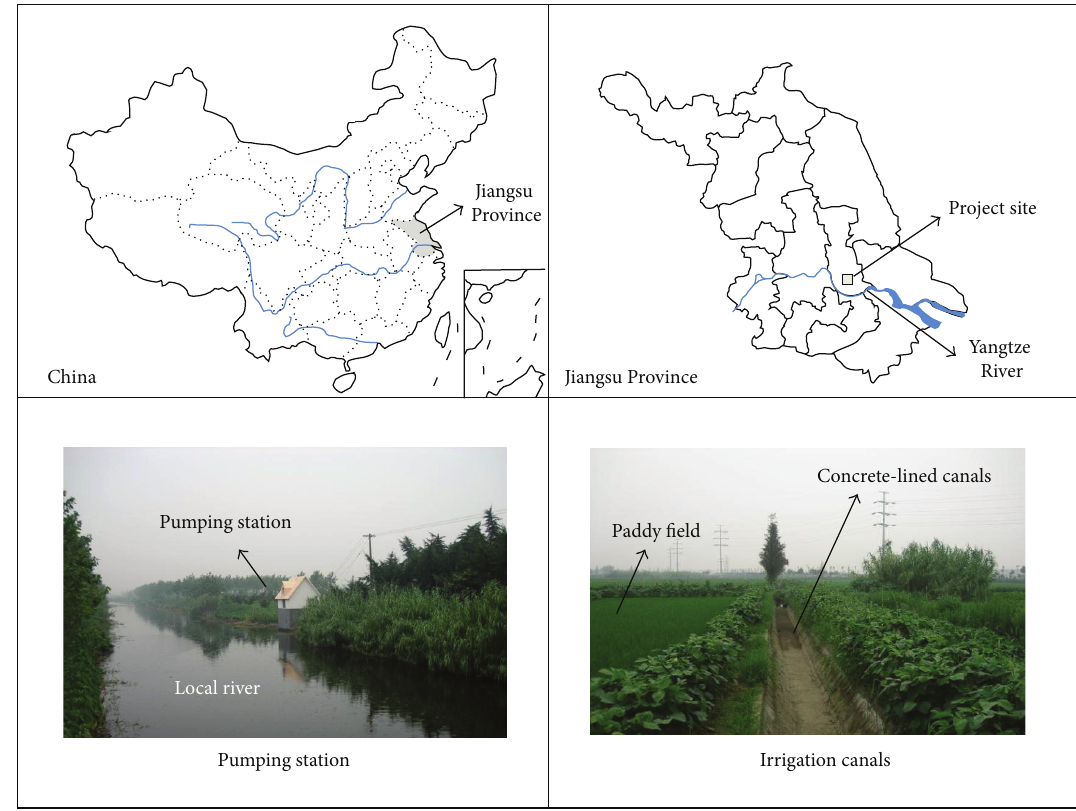
Figure 1: Location of the study area and the main irrigation